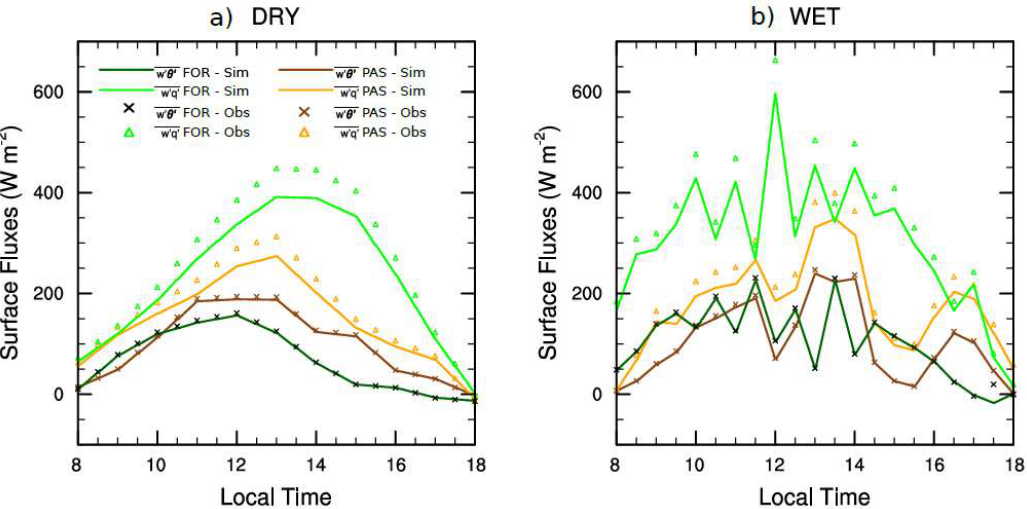
Figure 3. Time series of the prescribed (marks) and LES simulation horizontal mean (solid lines) of surface sensible ( a ) and latent ( b ) heat fluxes.